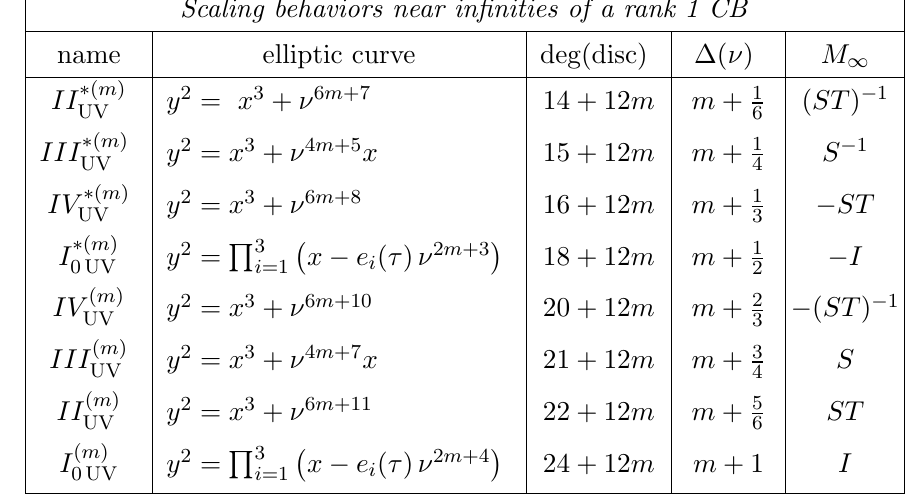
Table 3 . Weierstrass forms of rank 1 special K(cid:127)ahler a(cid:14)ne in(cid:12)nities at (cid:23) = 0 where (cid:10) = d(cid:23) ^ dx=y , i.e., in regular gauge. m (cid:21) 0 and n > 0 are integers. The third column gives the order of the zero of the discriminant of the curve at (cid:23) = 0, and the fourth column gives the counter-clockwise SL(2 ; Z ) monodromy around (cid:23) =